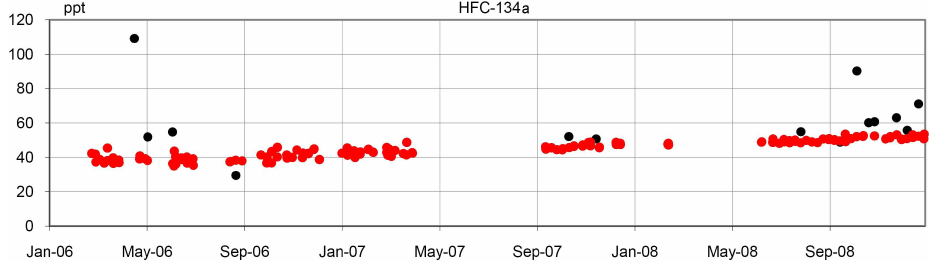
Fig. 2. Time series for HFC-134a at the NCO-P. Red dots, baseline data. Black dots, not-baseline data.